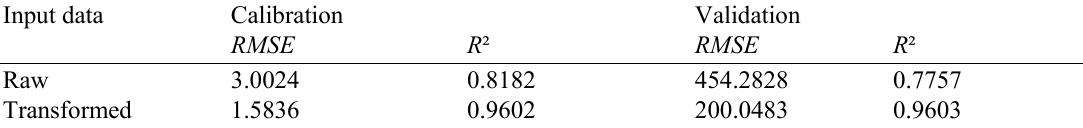
Fig. 4 Forecasting seven days ahead using the approximation A 3 , in which Q o and Q c are the observed and calculated inflows (WA-ANN model), respectively. Table 1 Statistical indexes during the calibration and validation using the raw and transformed